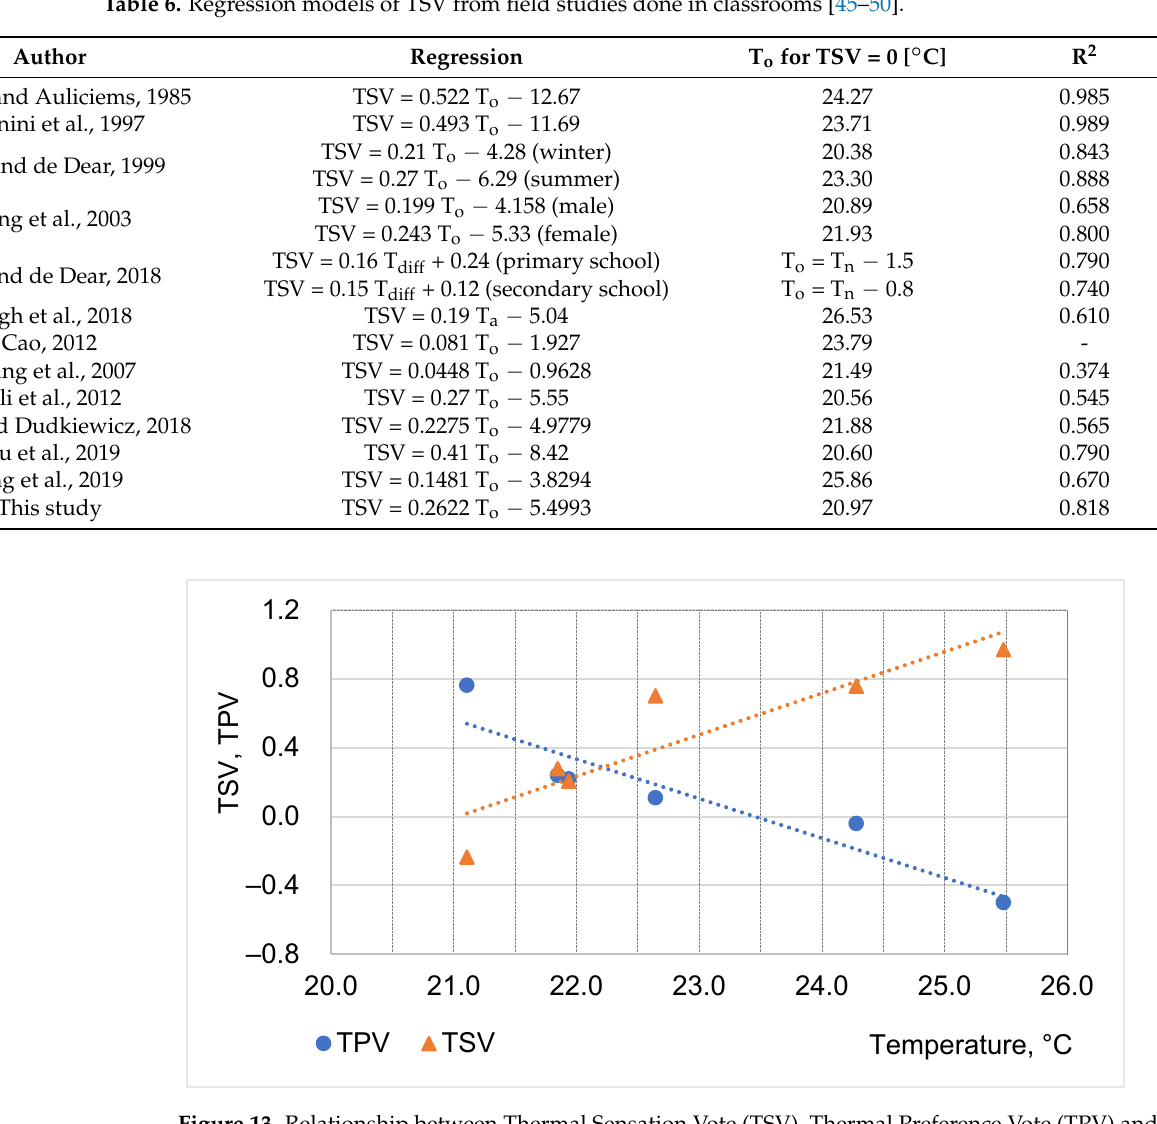
Figure 13. Relationship between Thermal Sensation Vote (TSV), Thermal Preference Vote (TPV) and operative temperature T o .